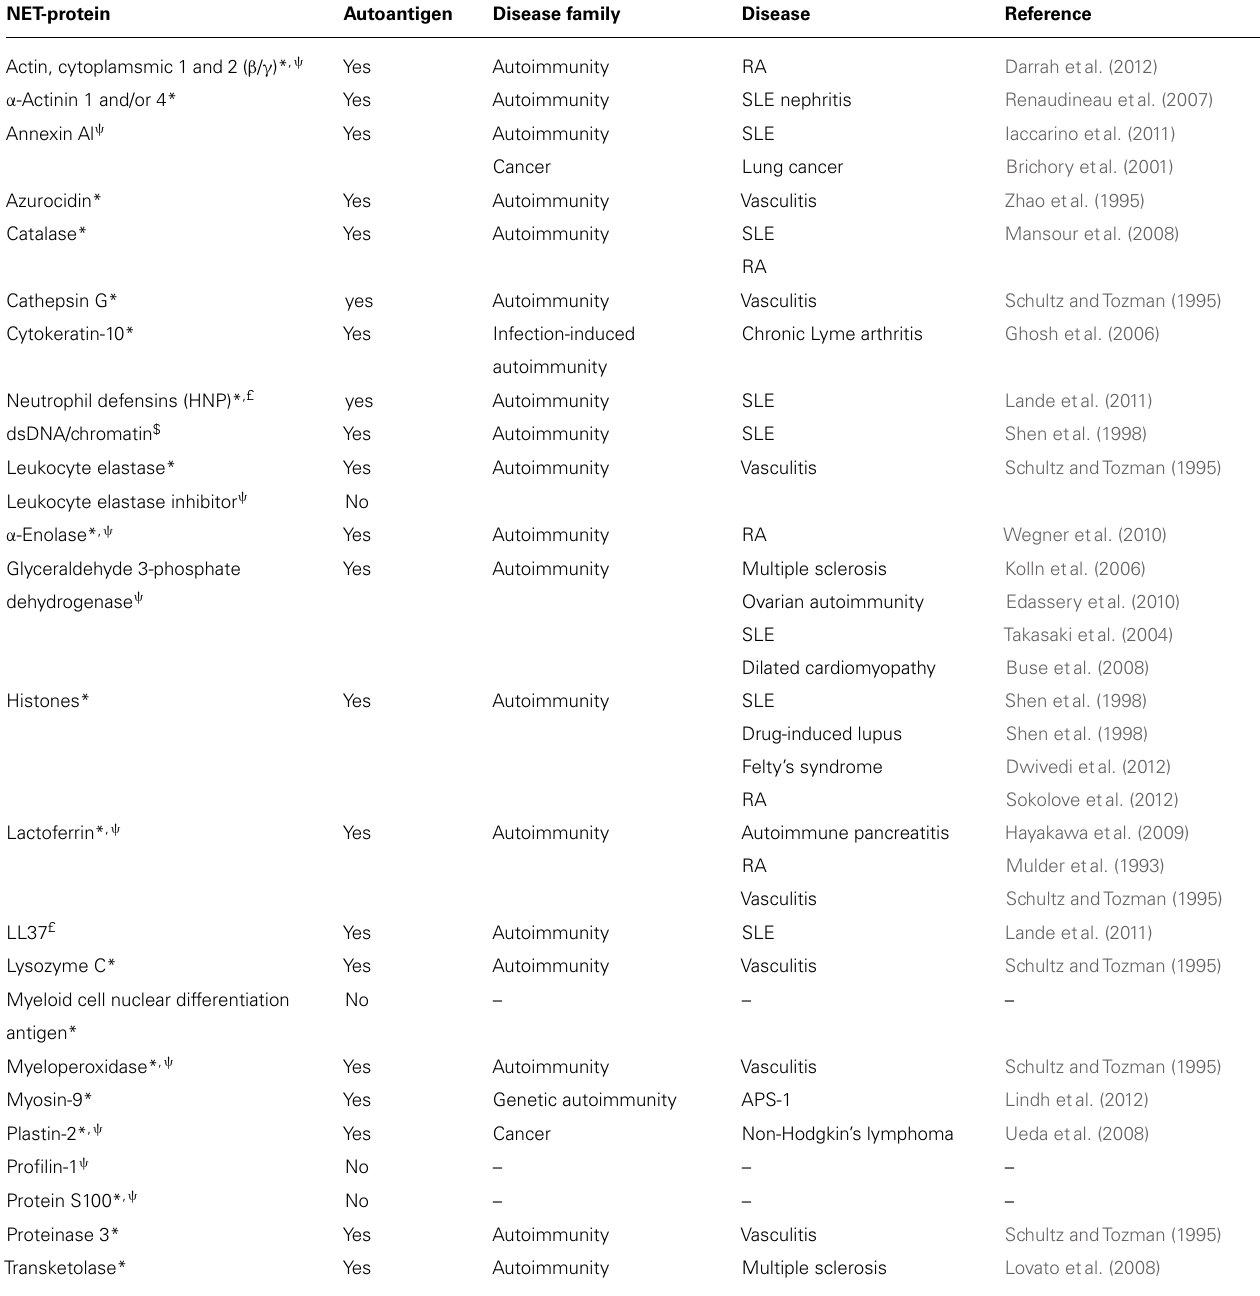
Table 1 |Autoantigens are enriched in